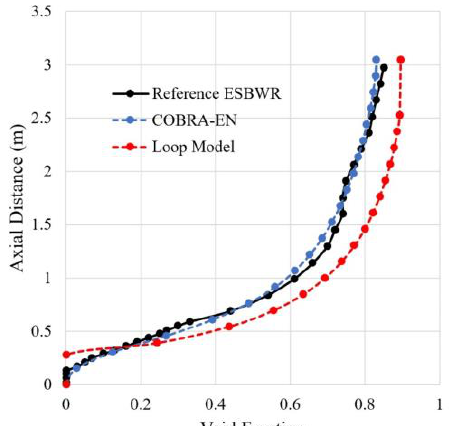
Figure 4. Comparison of The Thermal Hydraulic Models in Capturing ESBWR Core Void